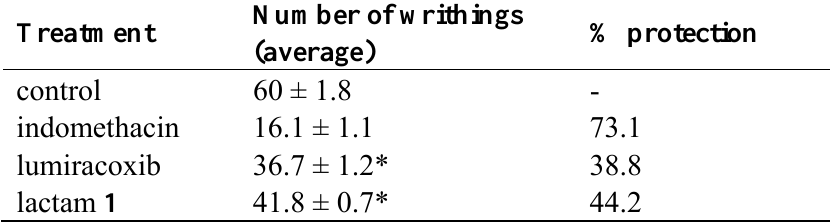
Table 2. Number of writhings and percentage of protection by indomethacin, lumiracoxib and lactam 1 at 100 μ mol Kg − 1 , using the acetic acid induced writhing model in mice (n = 6, mean ± S.D.).